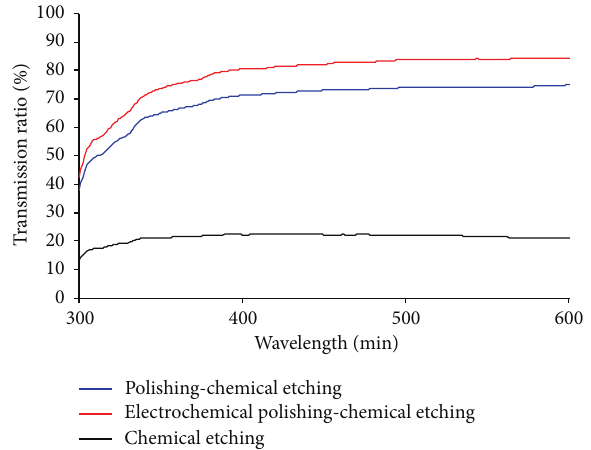
Figure 10: Transmission ratio curves of the TiO 2 nanotube arrays grown on etching Ti